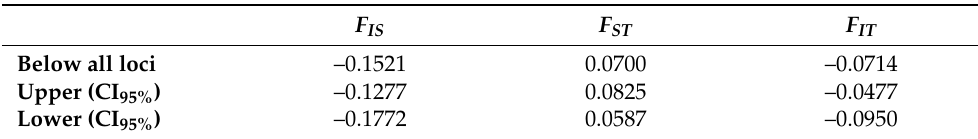
Table 2. Results of estimates from Wright’s F statistics obtained for 15 populations of A. aculeatum using ten specific microsatellite loci. F